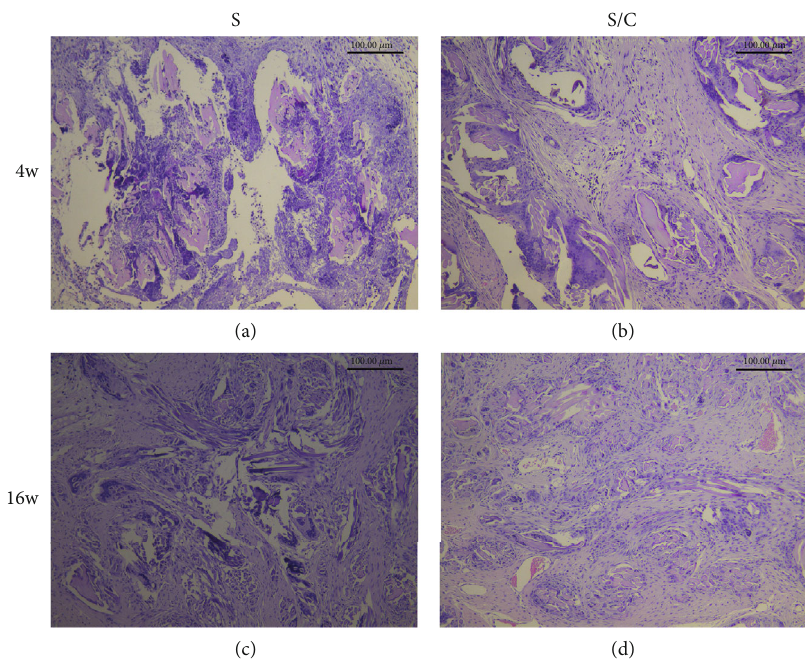
Figure 5: At 4 weeks after surgery, HE staining of grafts in the knee cavity in the S group (a) revealed few cells, whereas considerable cells were observed in the core part of the graft in the S/C group (b). At 16 weeks after surgery, fi broblast-like cells became more regular and denser in the S/C group (d) than in the S group (c).